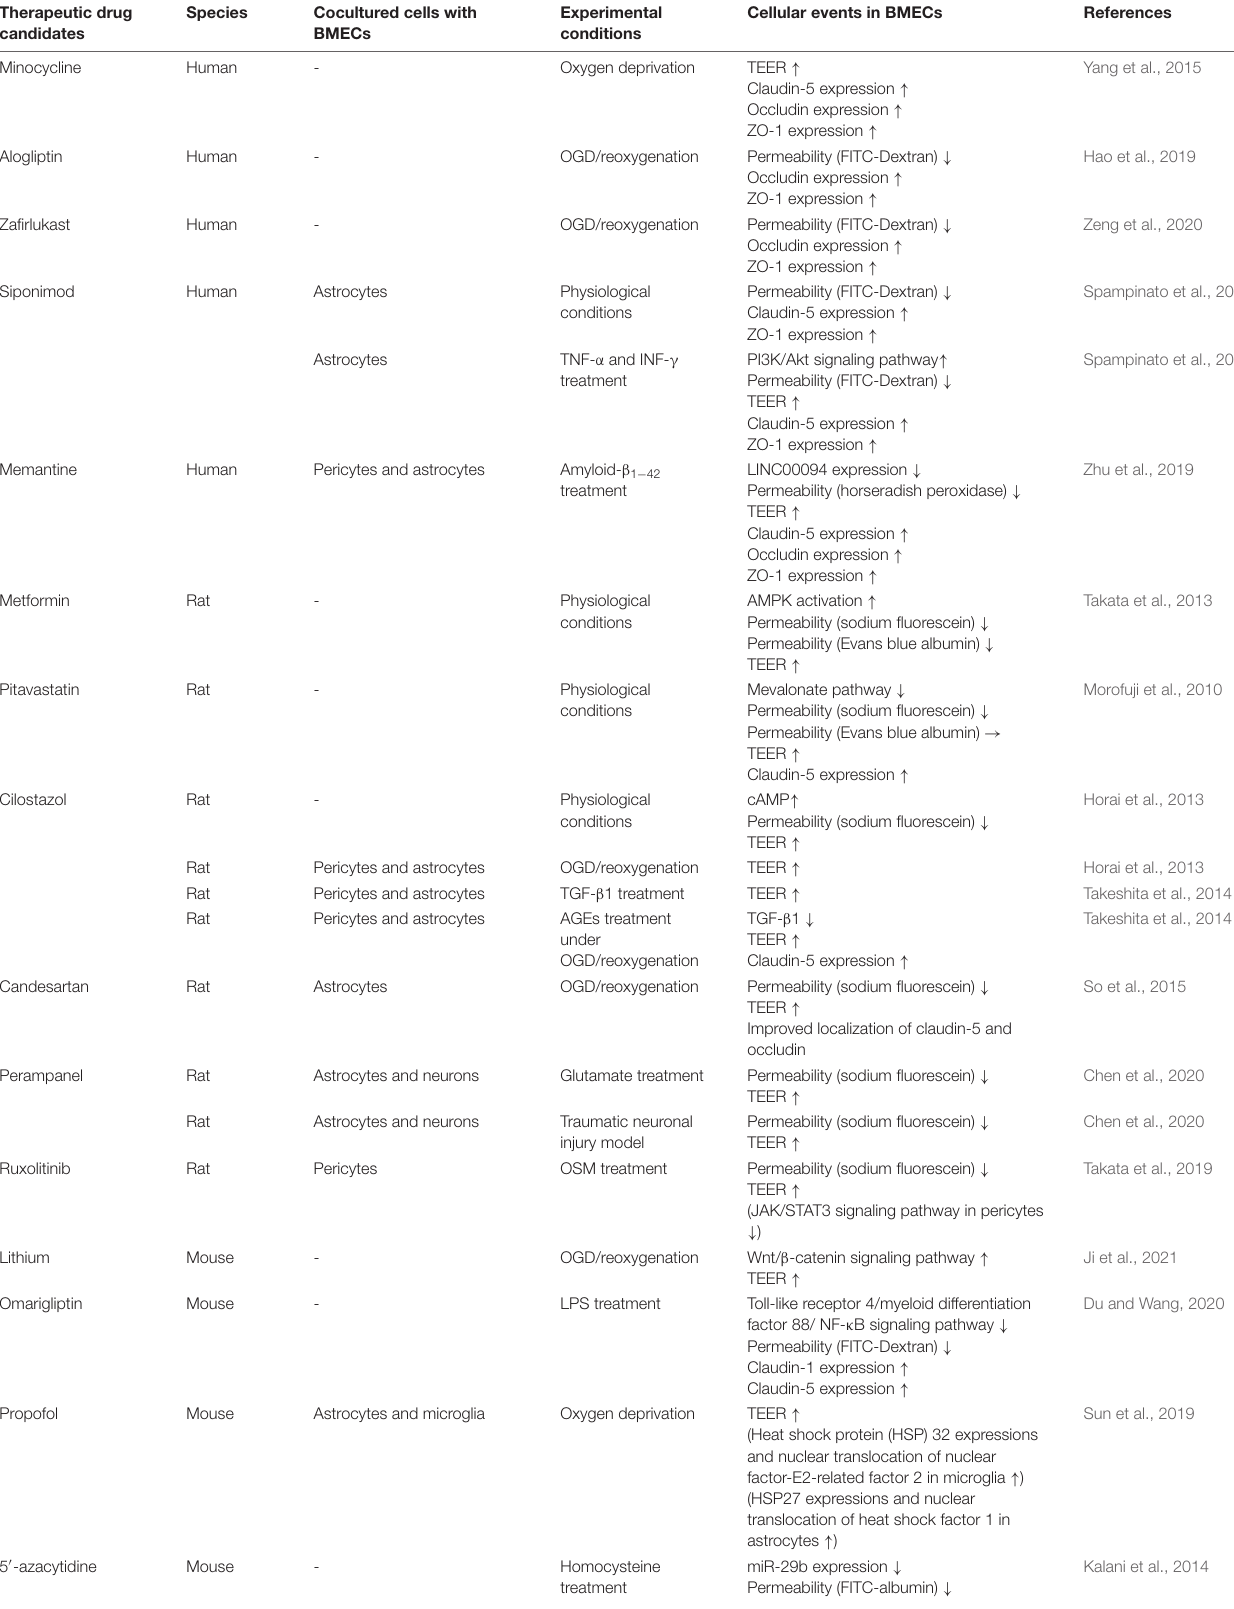
TABLE 3 | Therapeutic drug candidates for modulating BBB integrity. Therapeutic drug